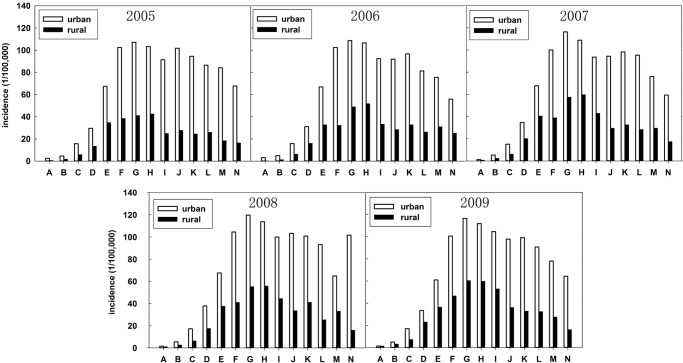
Female breast cancer incidence in different age groups during 2005–2009a.
a Age groups: A: 0–24, B: 25–29, C: 30–34, D: 35–39, E: 40–44, F: 45–49, G: 50–54, H: 55–59, I: 60–64, J: 65–69, K: 70–74, L: 75–79, M: 80–84, N: > 85.